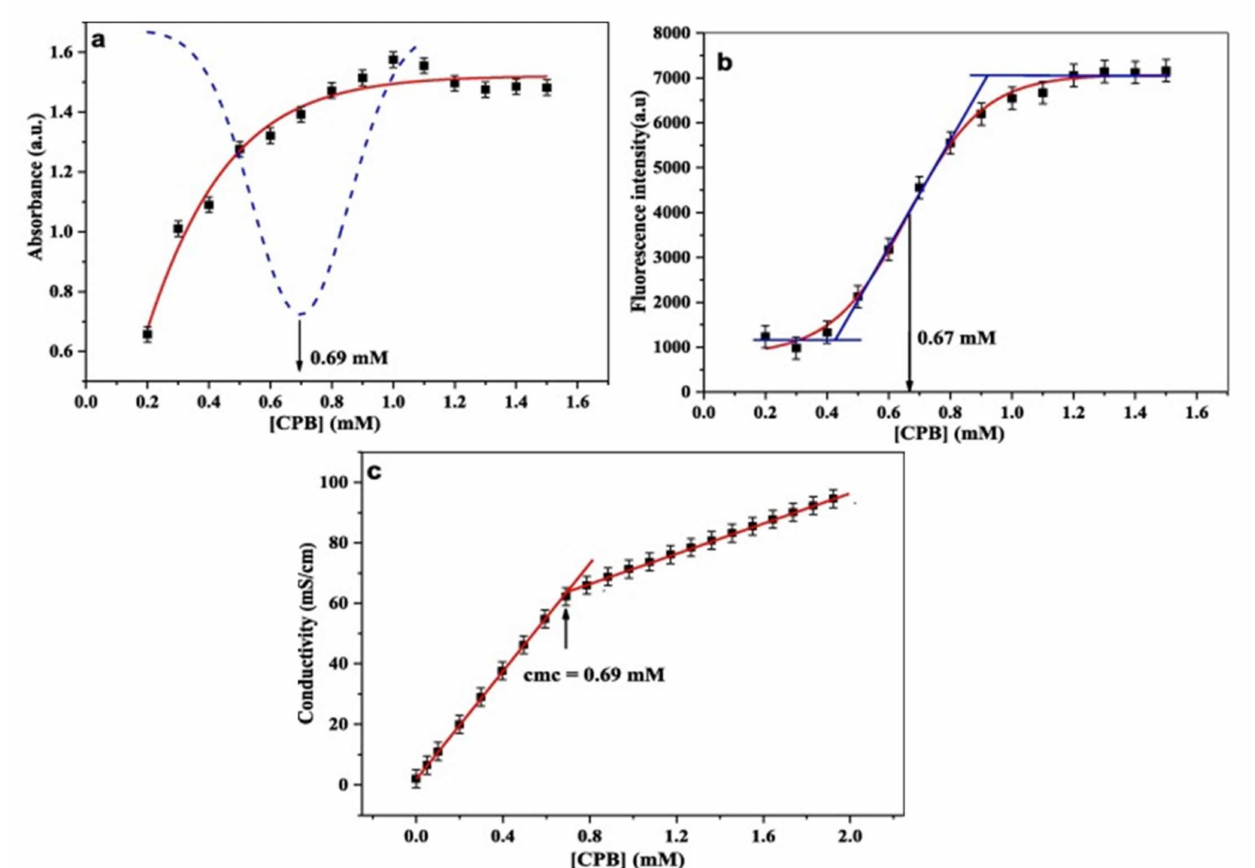
Figure 2. CMC measurement of CPB using absorbance ( a ), fluorescence ( b ), and conductivity ( c ) as related to concentration of CPB. Reprinted from [36], Copyright (2019) with permission from